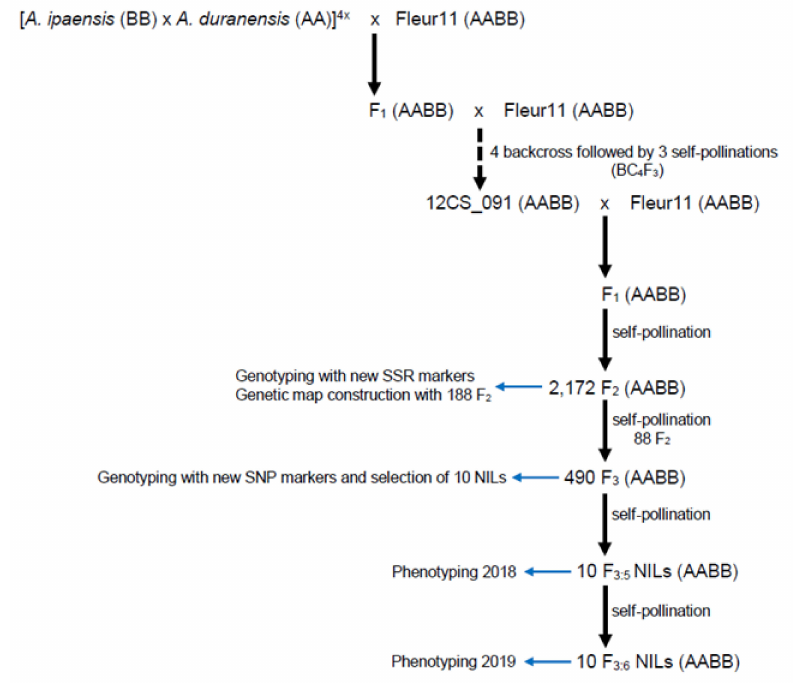
Figure 1. Selection scheme for NILs